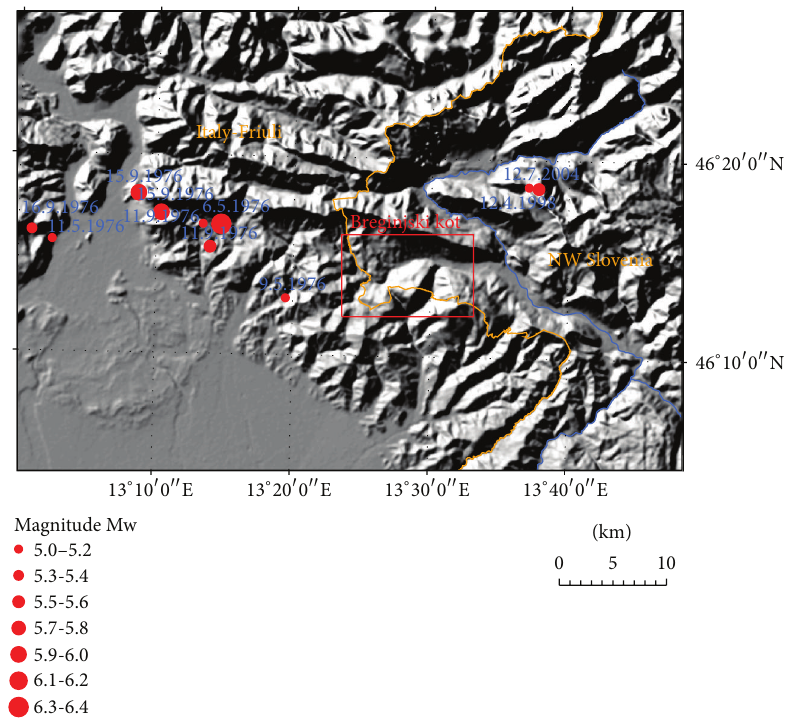
Figure 1: Seismicity (Mw ≥ 5.0) in Friuli and NW Slovenia with location of Breginjski kot study